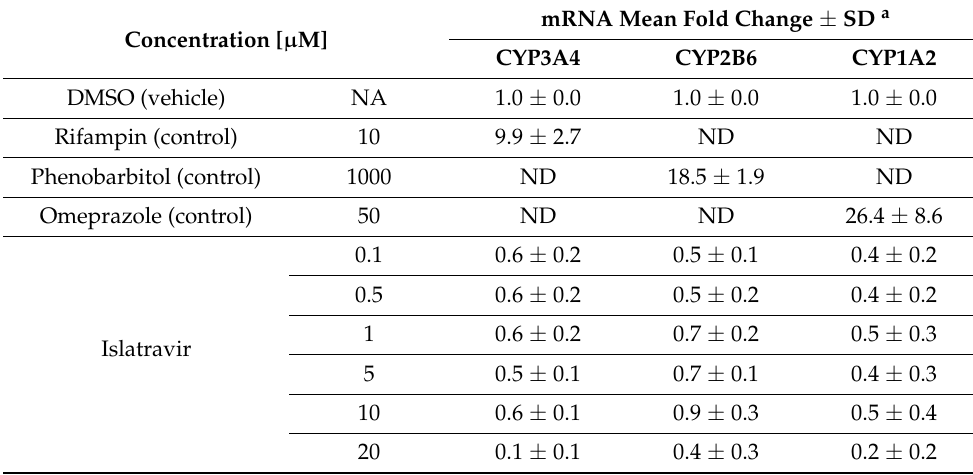
Table 3. Effect of islatravir on CYP mRNA in human